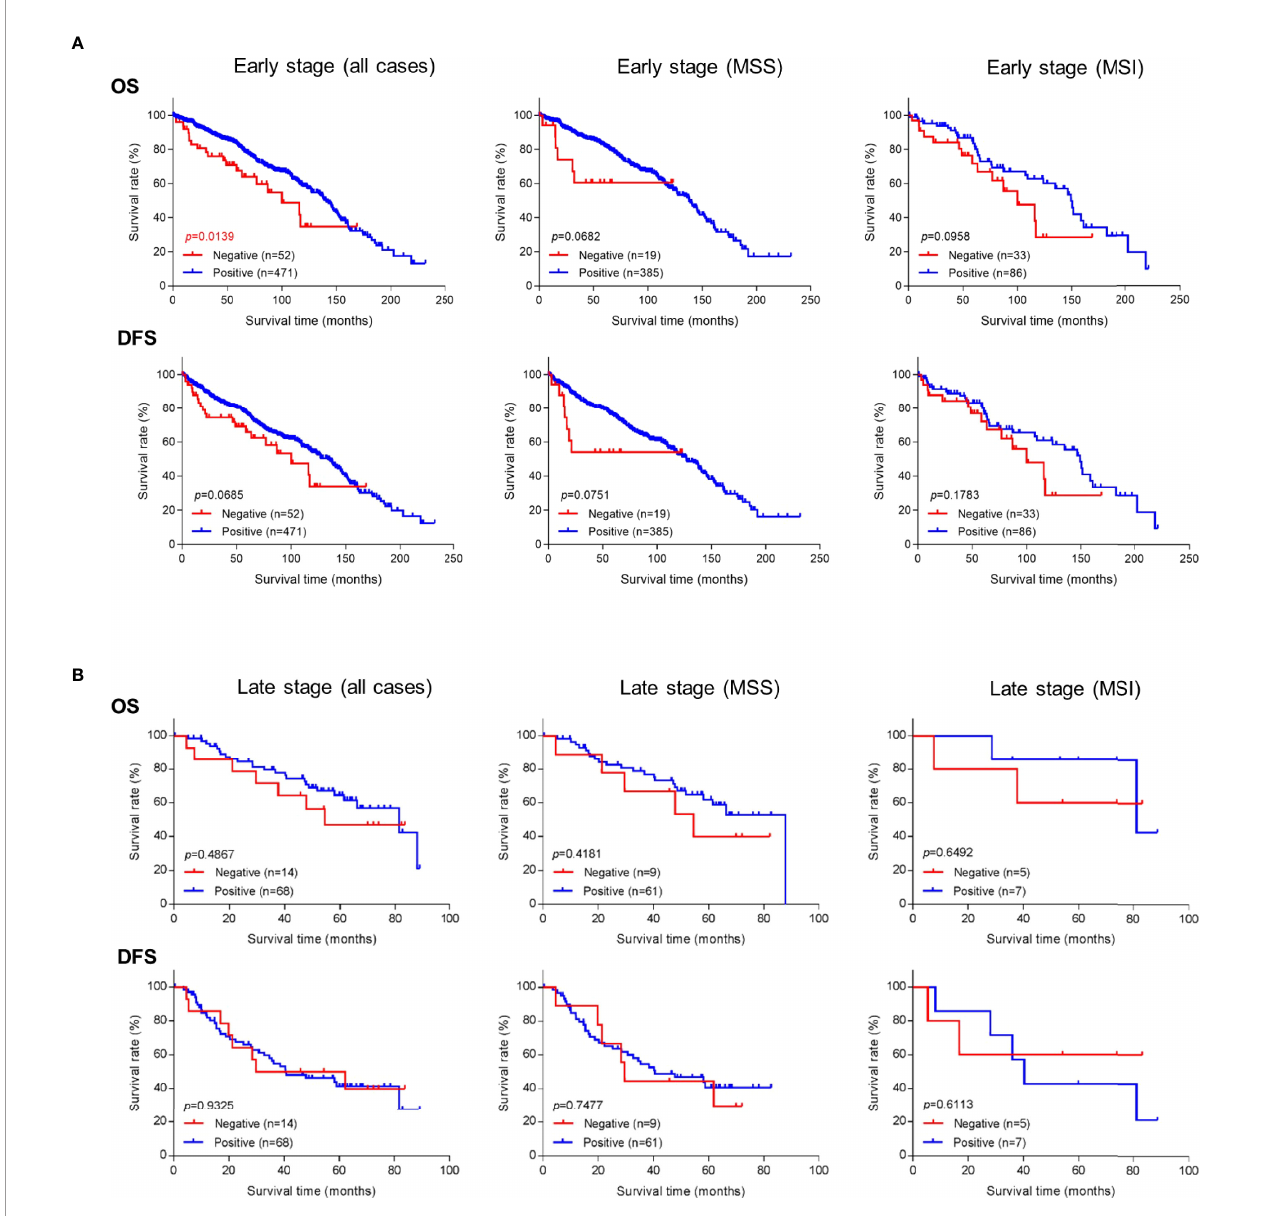
FIGURE 3 | Overall survival (OS) or disease-free survival (DFS) in (A) early-stage and (B) late-stage colorectal cancer as a function of GALNT6 protein expression status (positive/retained or negative/lost). Loss of GALNT6 is associated with shorter survival in early-stage